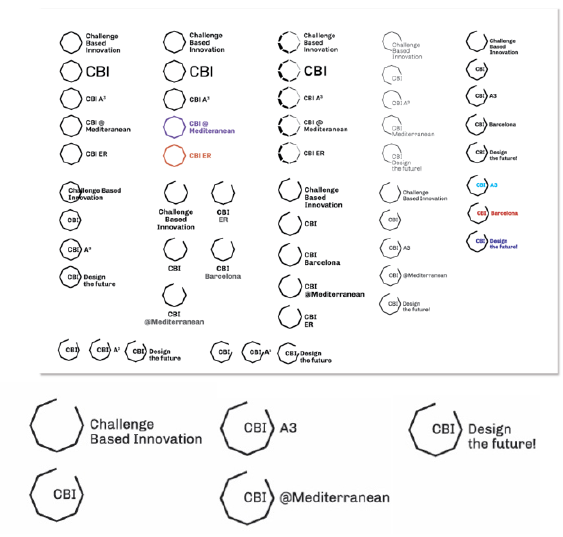
Fig. 9. Examples of exploration of the CBI logo and a highlighted example of this exploration.